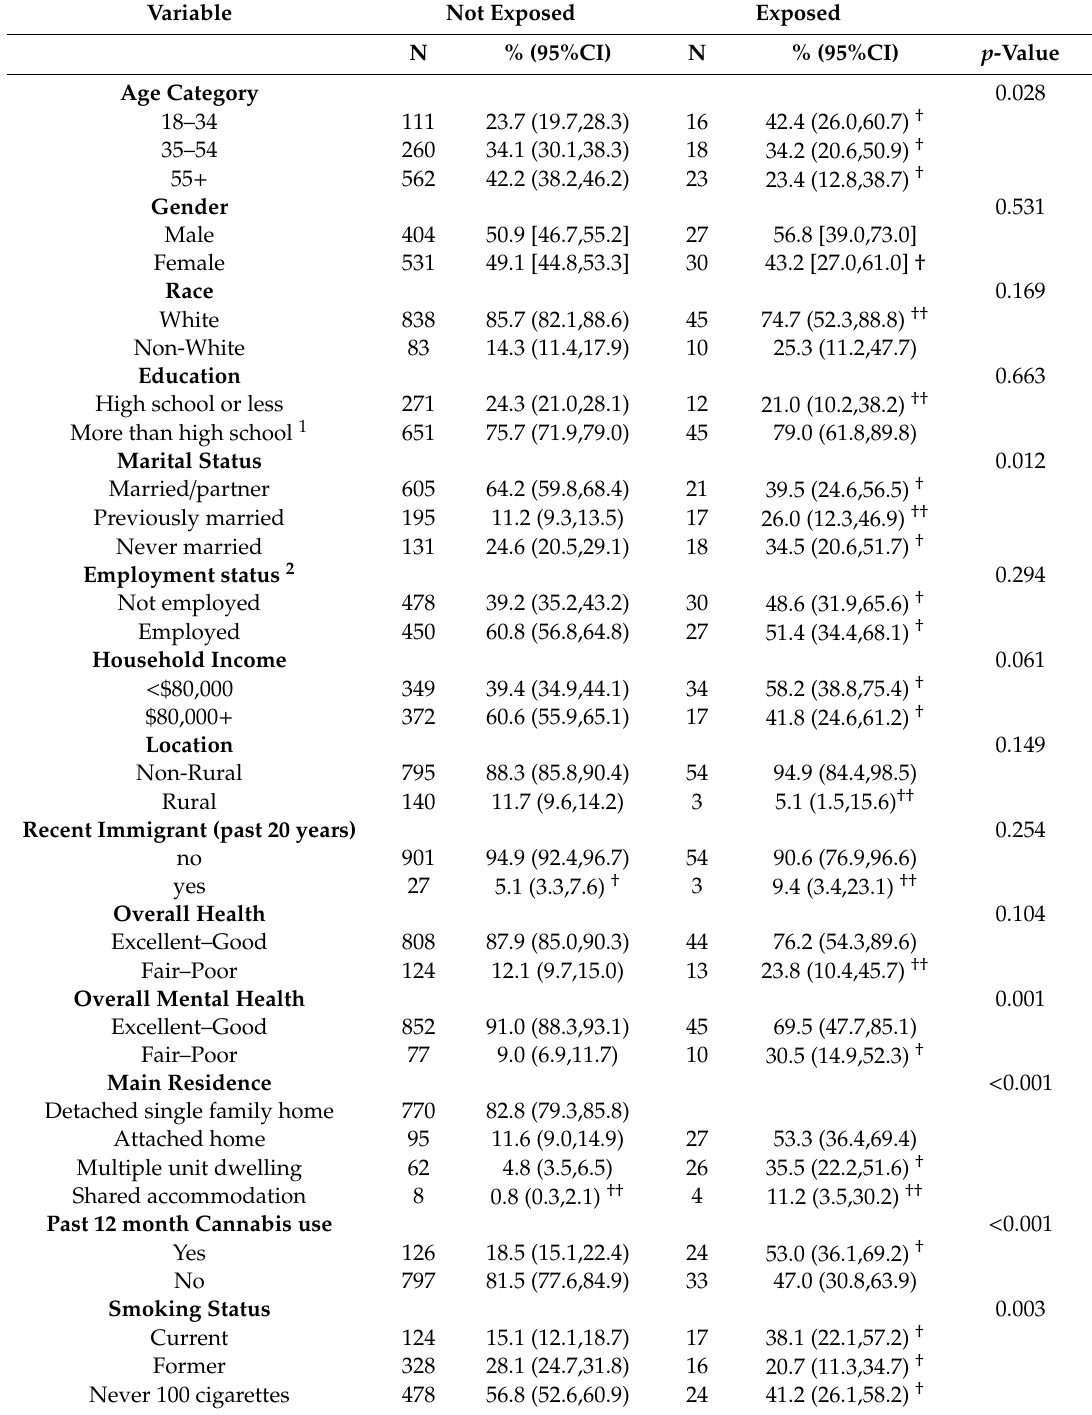
Table 2. Prevalence of Exposure to Environmental Cannabis Smoke, Ontario, Canada, 2017.